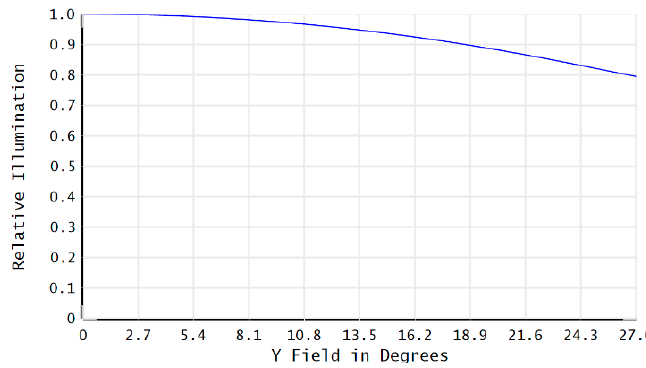
Figure 7. The field curvature and distortion of the objective lens. Appl. Sci. 2020 , 10 , x FOR PEER REVIEW